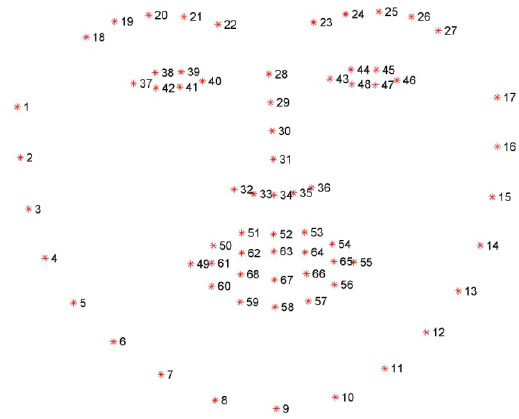
Figure 2: 68 point Facial